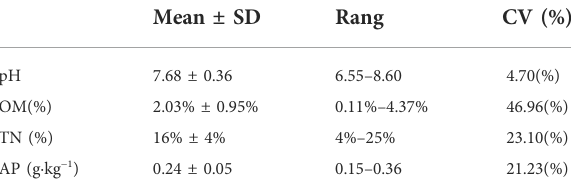
TABLE 5 Physico-chemical properties of the soil samples from the study area.